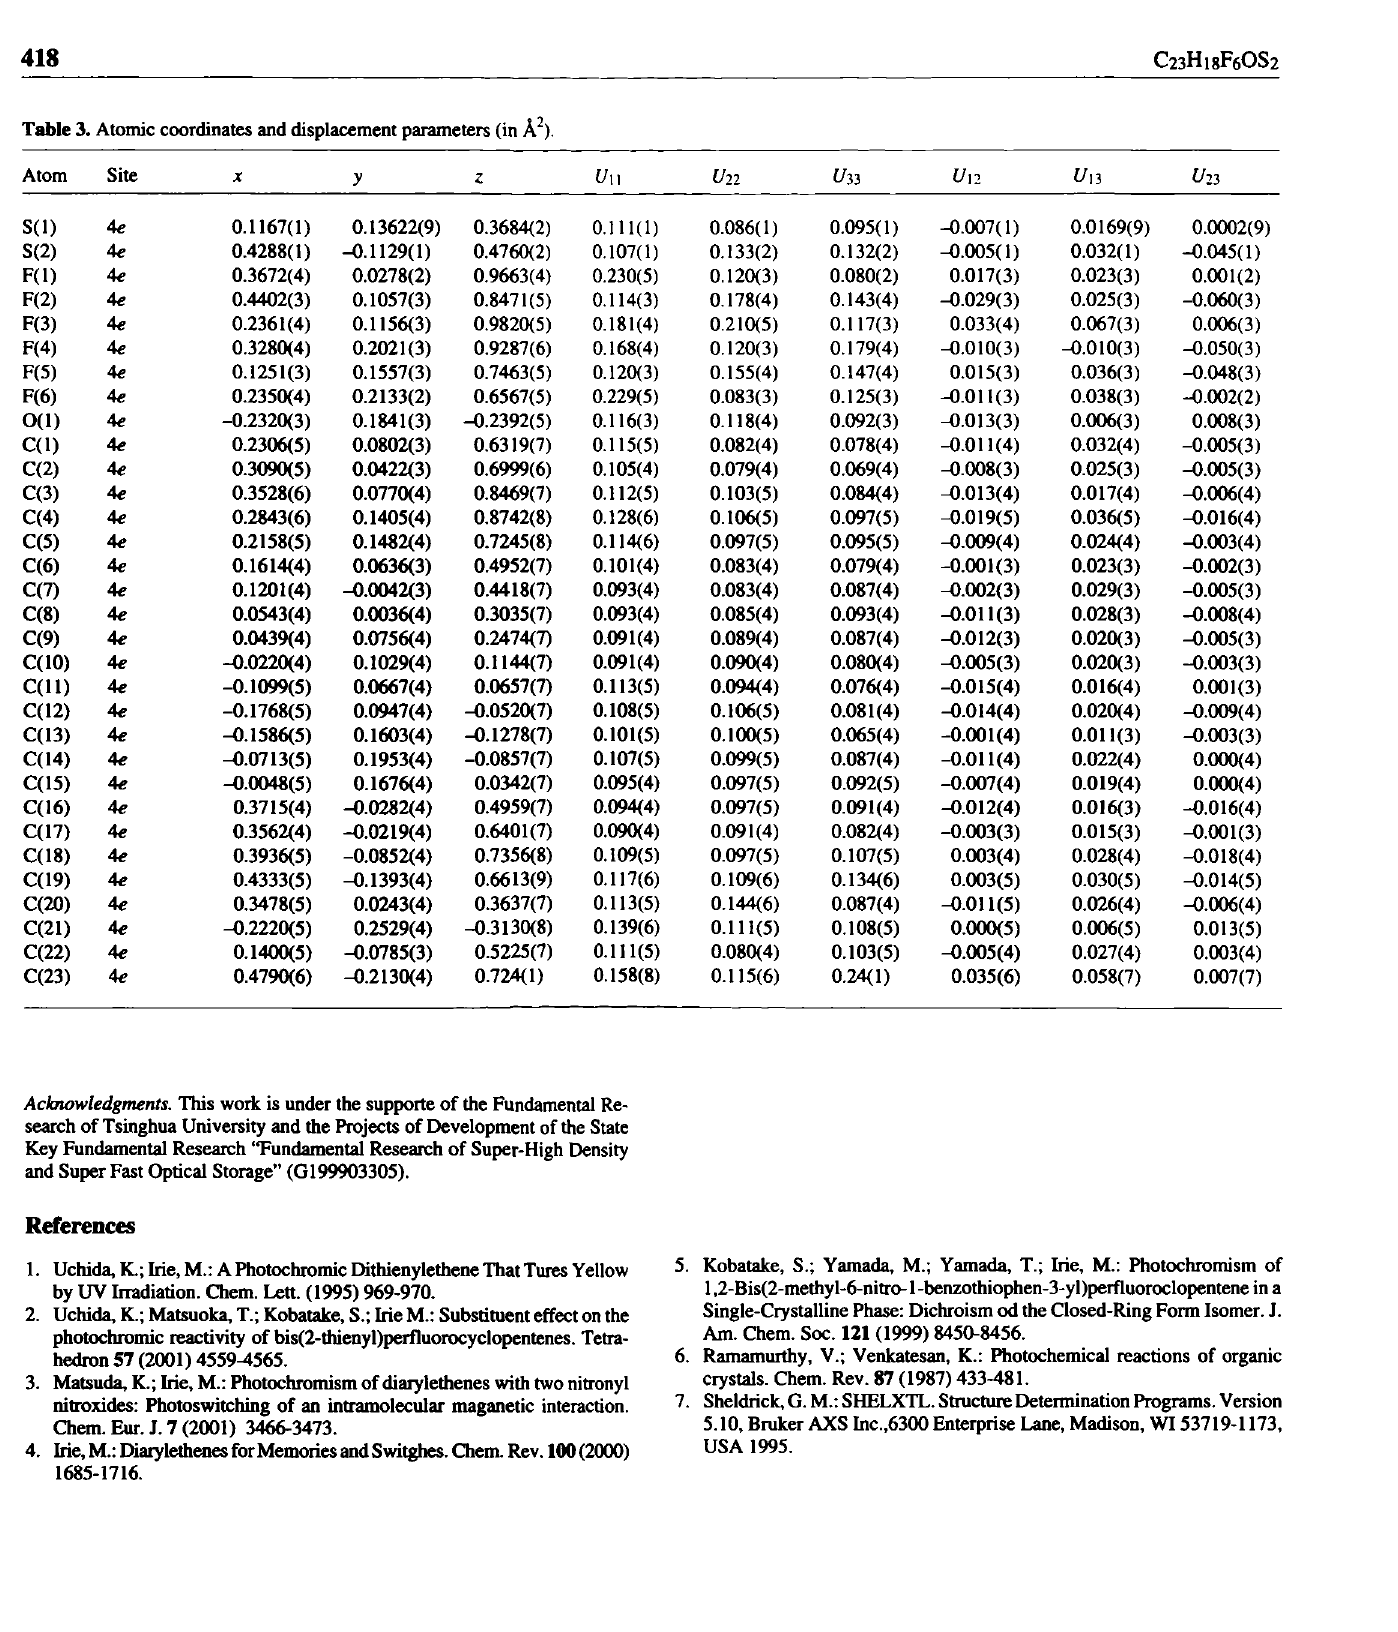
Table 3. Atomic coordinates and displacement parameters (in Â 2